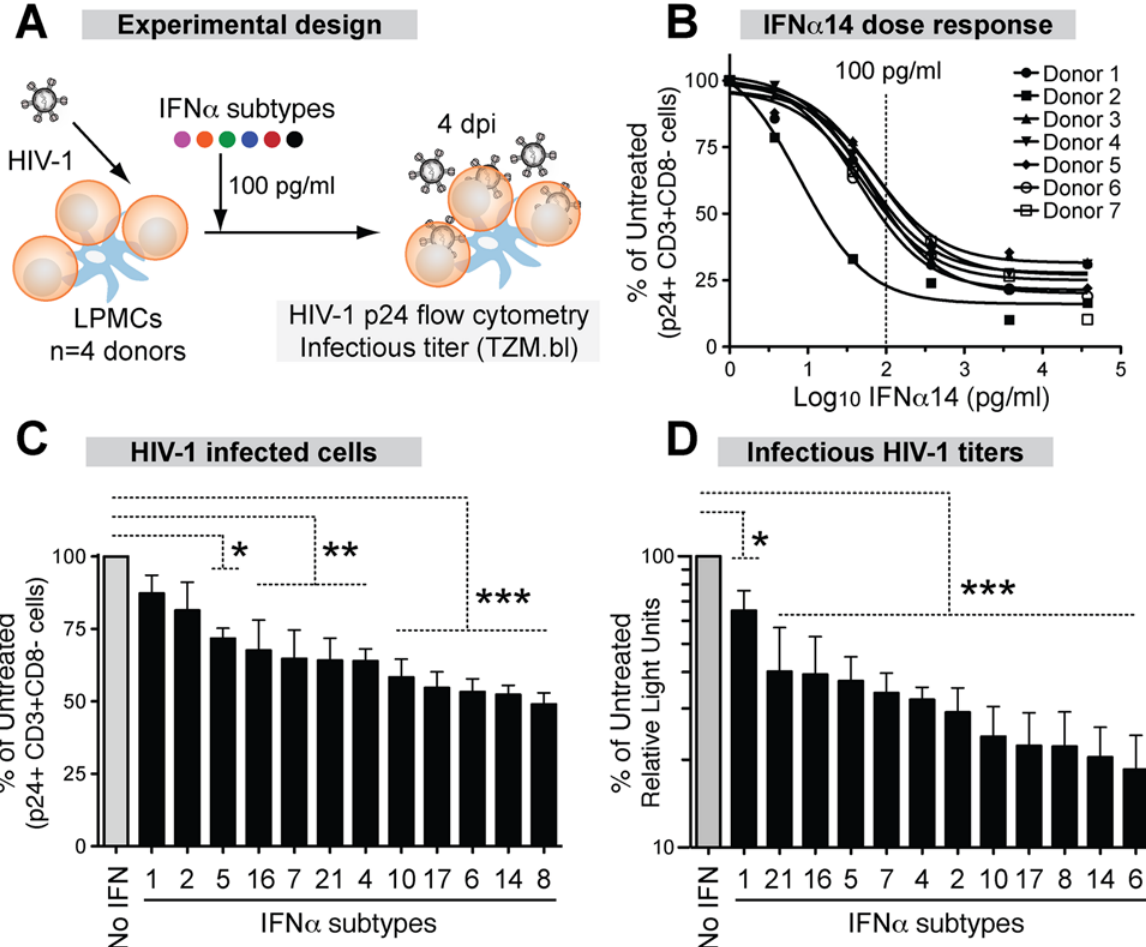
Fig 2. Inhibition of HIV-1 by 12 IFN α subtypes in the LPAC model. (A) LPMCs (n = 4 donors) were infected with HIV-1 BaL (10 ng p24/10 6 cells) by spinoculation for 2 hrs. Each IFN α subtype was added individually at 100 pg/ml, and cells were harvested at 4dpi. (B) Dose-response curve of IFN α 14 for inhibition of HIV-1 infection (p24+CD3+/CD8- lymphocytes). Vertical dashed line indicates the IFN α dose used for subsequent experiments. Inhibition of (C) cellular HIV-1 infection and (D) infectious titer, normalized to untreated samples. Bars correspond to the means with SEM error bars from 4 LPMC donors. The x-axis was arranged from the least to the most potent IFN α subtype. Repeated measures ANOVA with Dunnett ’ s multiple comparison test was performed on raw infection values. Pairwise comparisons were each against the no IFN α control. ns, not significant at p > 0.05; * , p < 0.05; ** , p < 0.01; *** , p <